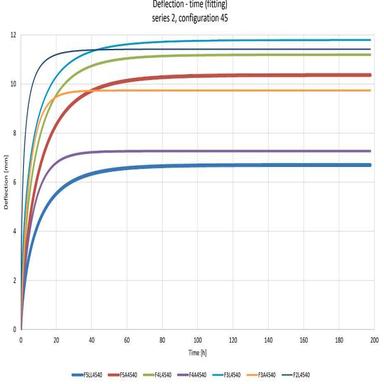
The ideal trends of the second series, "configuration 90", obtained from the curve fitting.